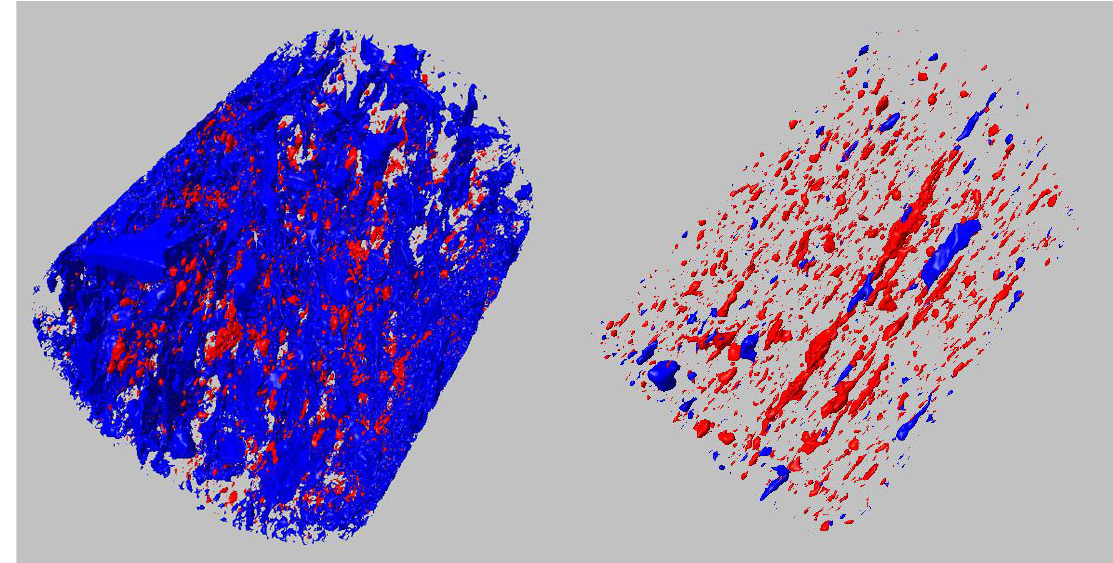
Figure 6. Ratio of pores that are accessible to any surface and the interior-only pores by firing tem- perature for each ceramic type (mean of 2).